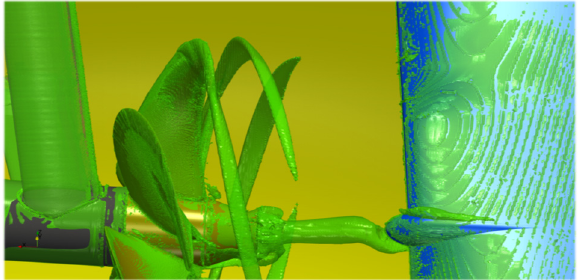
Figure 16. Near Wall Q-criterion Q = 5 · 10 4 s − 2 isosurface on shaft brackets, propeller, and rudder